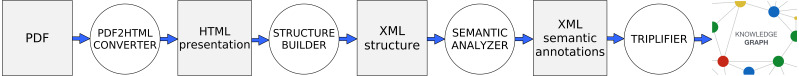
An overview of the PACO toolchain composed of four sub-modules (circles). Artifacts (i.e., inputs/outputs of the sub-modules) are depicted as rectangles.